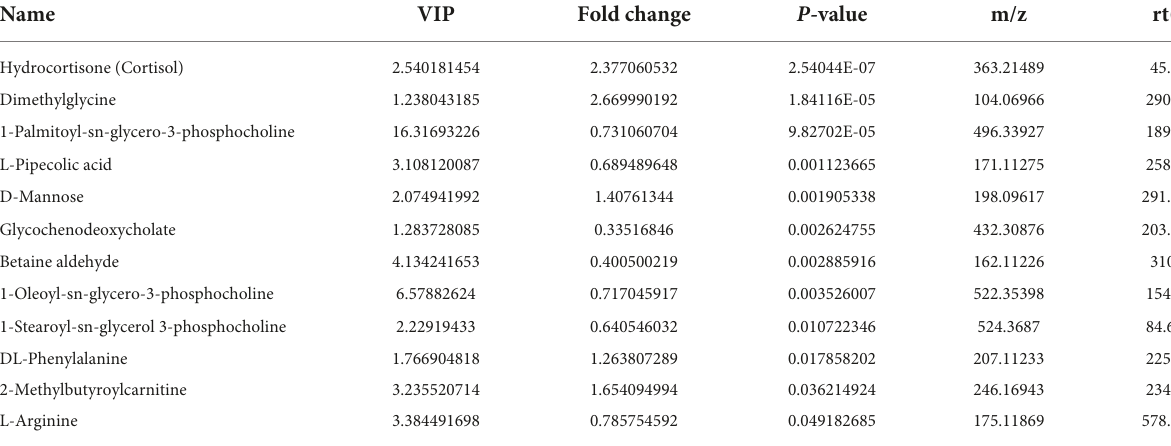
TABLE 2 Statistical analysis of different metabolites in positive ion patterns.